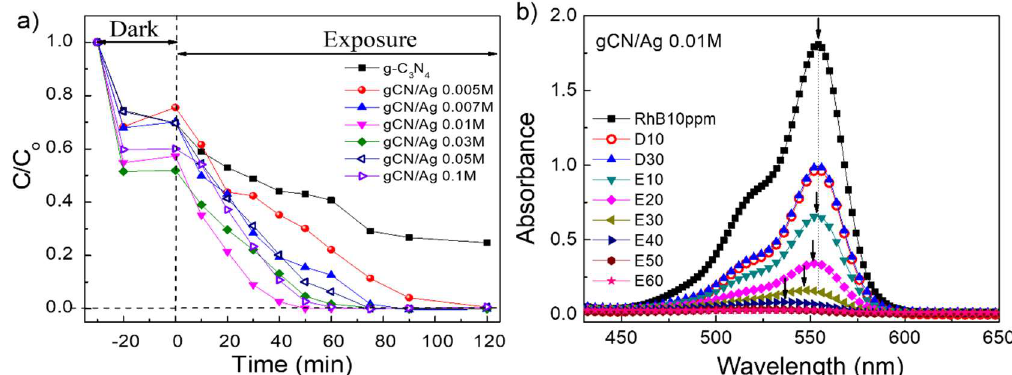
Figure 6. ( a ) Photocatalytic activities of the g-C 3 N 4 nanosheets and g-C 3 N 4 /Ag heterojunctions with different Ag + concentrations for degradation of RhB under xenon lamp irradiation and ( b ) the sharp decrease of RhB concentration in UV-vis absorption spectrum of gCN/Ag 0.01M sample as a function of time (Dx refers to stirring in dark for x minutes and Ex refers to exposing under Xenon lamp irradiation for x minutes).